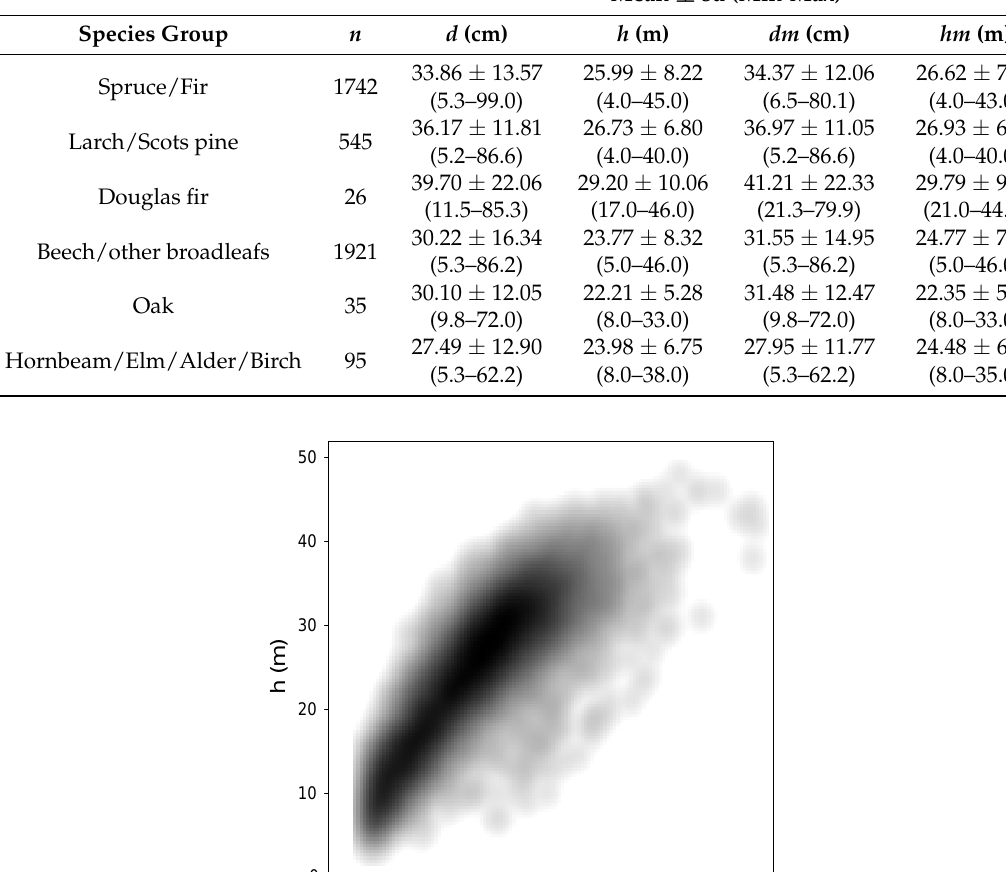
Table 5. Summary statistics of the evaluation data with respect to species groups. 𝑑 = diameter at breast height; ℎ = height; 𝑑𝑚 = diameter of the median basal area tree; ℎ𝑚 = height of the median basal area tree.